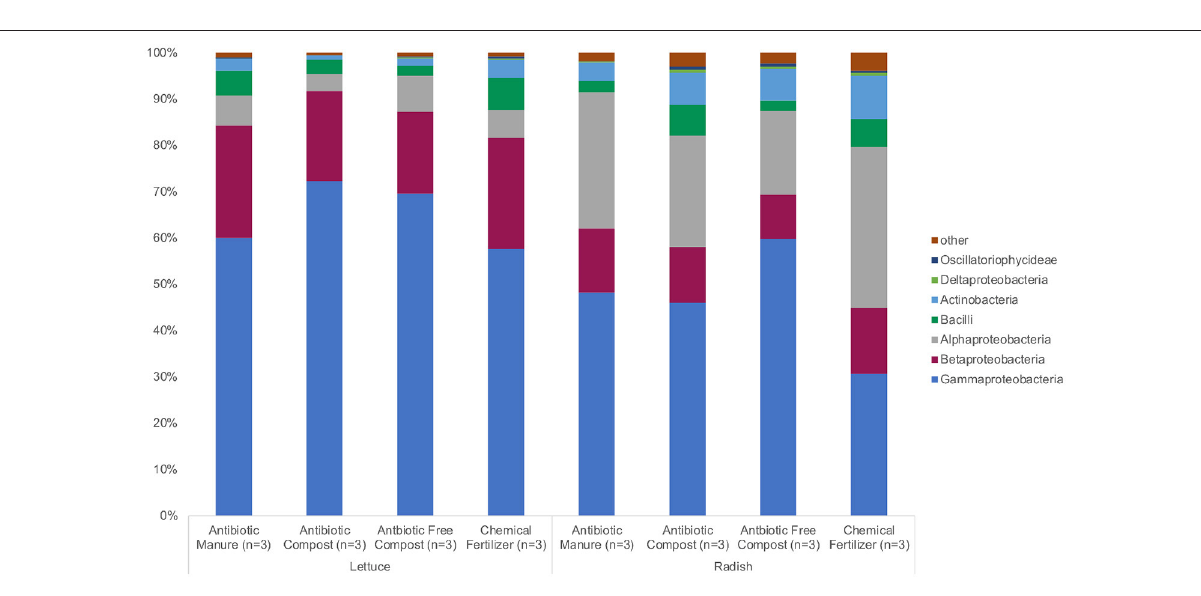
FIGURE 2 | Relative abundance of microbiota represented by 16S rRNA gene amplicon sequences recovered from field-grown lettuce and radish samples. No significant differences in relative abundance were detected using Wilcoxon with Steele-Dwass post-hoc